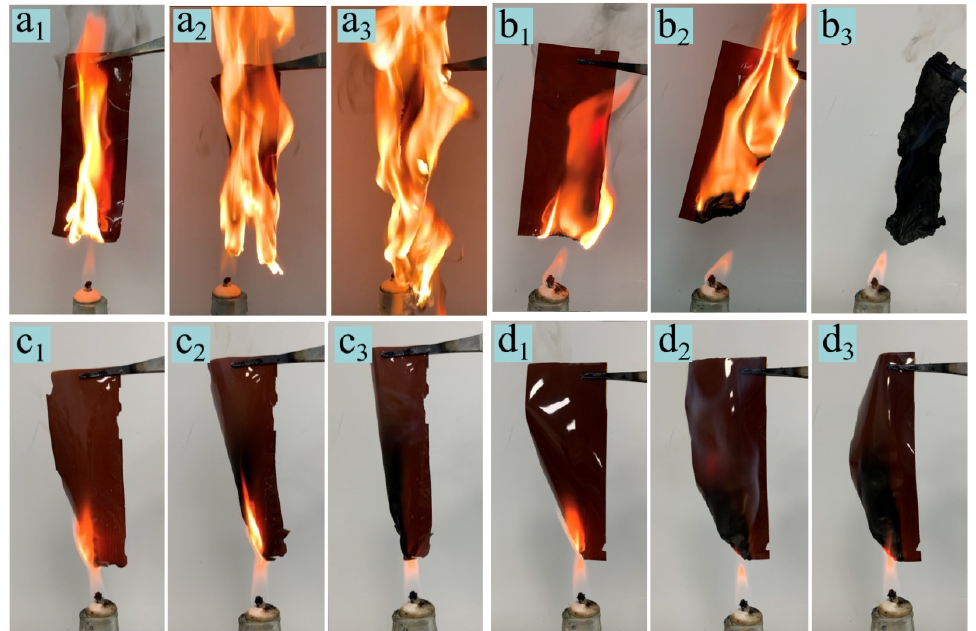
Figure 4. The combustion state of lacquer films with different FR contents in the air: ( a ) RL, ( b ) RL/10%IFR, ( c ) RL/20%IFR, and ( d ) RL/30%IFR. 1 is the initial state of combustion, 2 is the intermediate state of combustion and 3 is the final state of combustion.